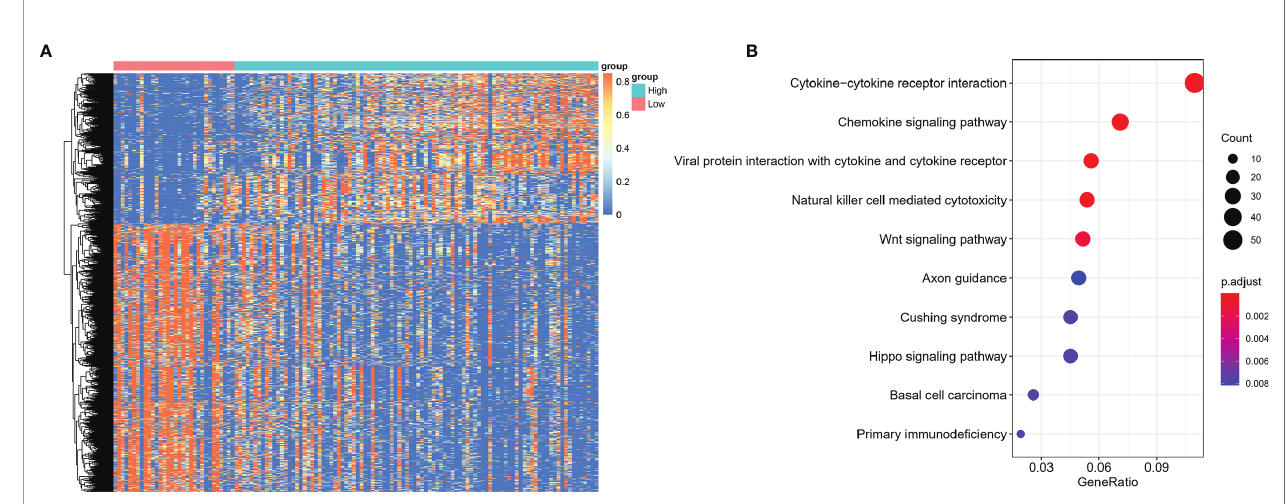
FIGURE 6 | Differentially expressed genes between NKTCL patients with high and low expression of CD56. (A) Heatmap shows the differentially expressed genes among groups, which were determined by signi fi cance criteria (abs(log2FC)>1 and adjusted P value<0.05) as implemented in the R package limma. The heatmap was drawn by pheatmap R package according to the differentially expressed genes. Unsupervised analyzing and hierarchical clustering of common differentially expressed genes based on expression data. (B) Gene annotation enrichment analysis using the clusterPro fi ler R package was performed on signature genes. The top fi ve pathways with the greatest enrichment were Cytokine-cytokine receptor interaction, Chemokine signaling pathway, Viral protein interaction with cytokine and cytokine receptor, Natural killer cell mediated cytotoxicity, Wnt signaling